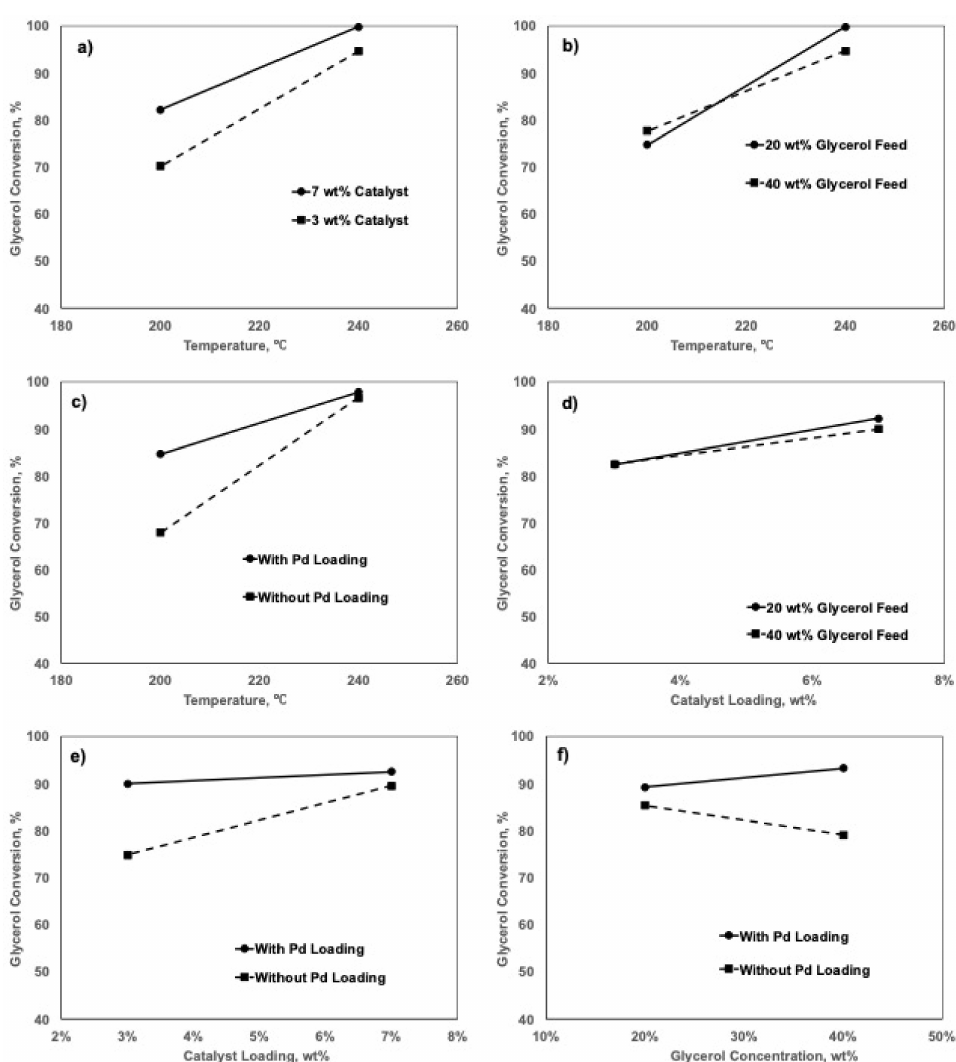
Figure A3. Two factor interactions on the glycerol